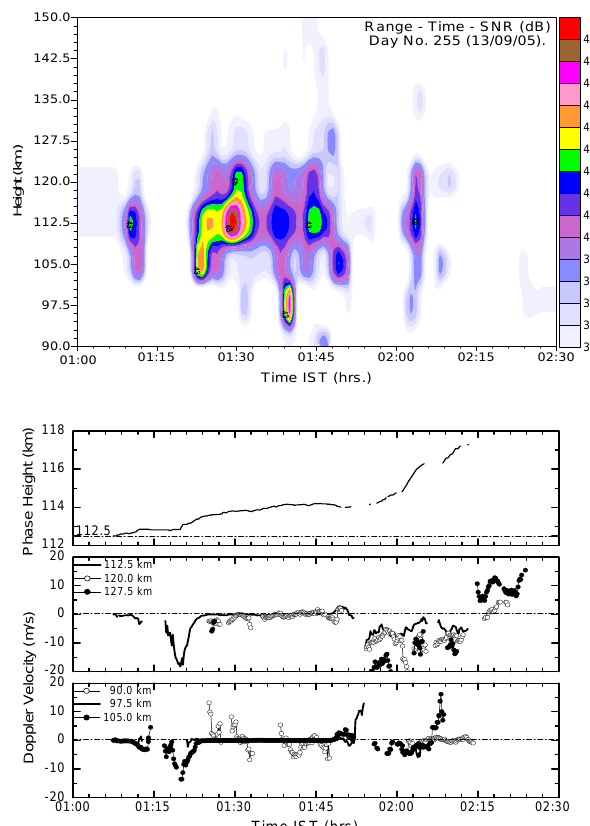
Fig. 6. Same as Fig. 2 except for the Day no. 256, 2005 (13 Septem- ber